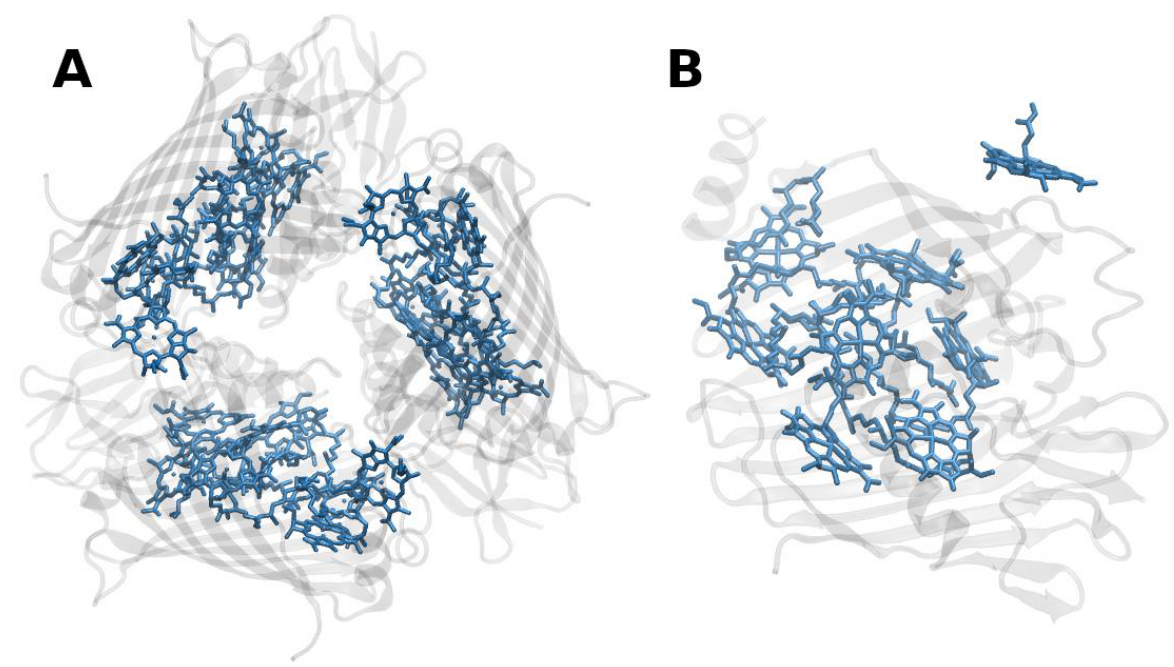
Figure 9. Structure of the water-soluble Fenna–Matthews–Olsen protein complex (FMO) from Prosthecochloris aestuarii at 1.3 Å resolution, PDB entry 3EOJ [104]. ( A ) Top view of the trimer with regard to the bacterial membrane plane, seen from the cytoplasm/chlorosome. ( B ) Side view of a single monomer with regard to the bacterial membrane plane. The protein backbone is shown in grey. Bacteriochlorophyll a is shown in blue.